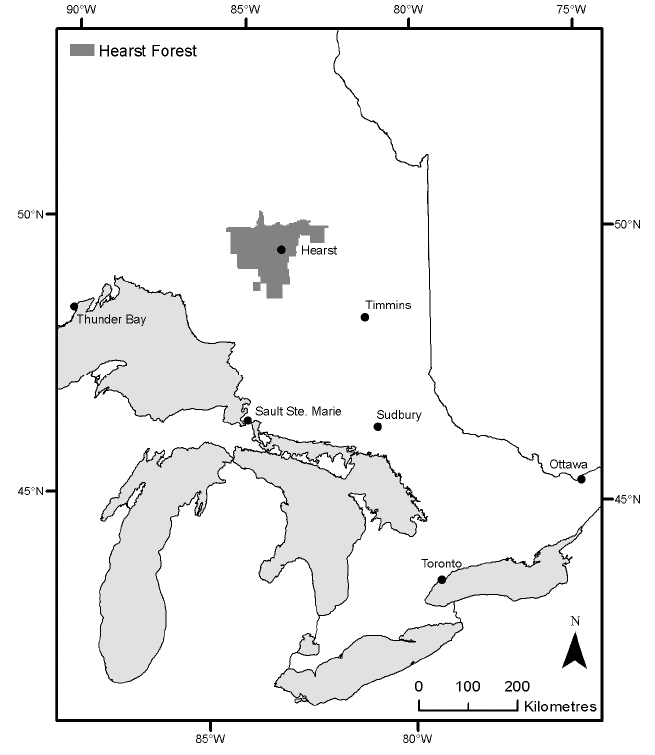
Figure 1. Map depicting Hearst, Ontario and surrounding